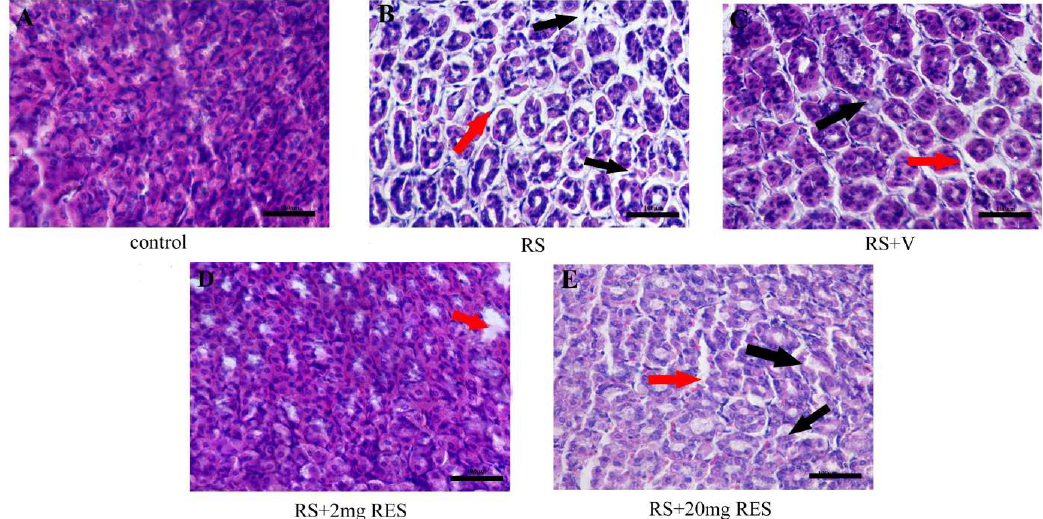
Figure 4. Histopathologic analysis of parietal cells of non-stressed mice (Control), restraint-stressed mice (RS), restraint-stressed mice with vehicle (RS + V), restraint-stressed mice treated with 2 mg/kg body weight of resveratrol (RS + 2 mg RES), and restraint-stressed mice treated with 20 mg/kg body weight of resveratrol (RS + 20 mg RES) using H&E staining. Red arrowheads point to an acute loss of parietal cells. Black arrowheads point to severe damage to the general structure of the gastric mucosa. Scale bar is 100 μm.